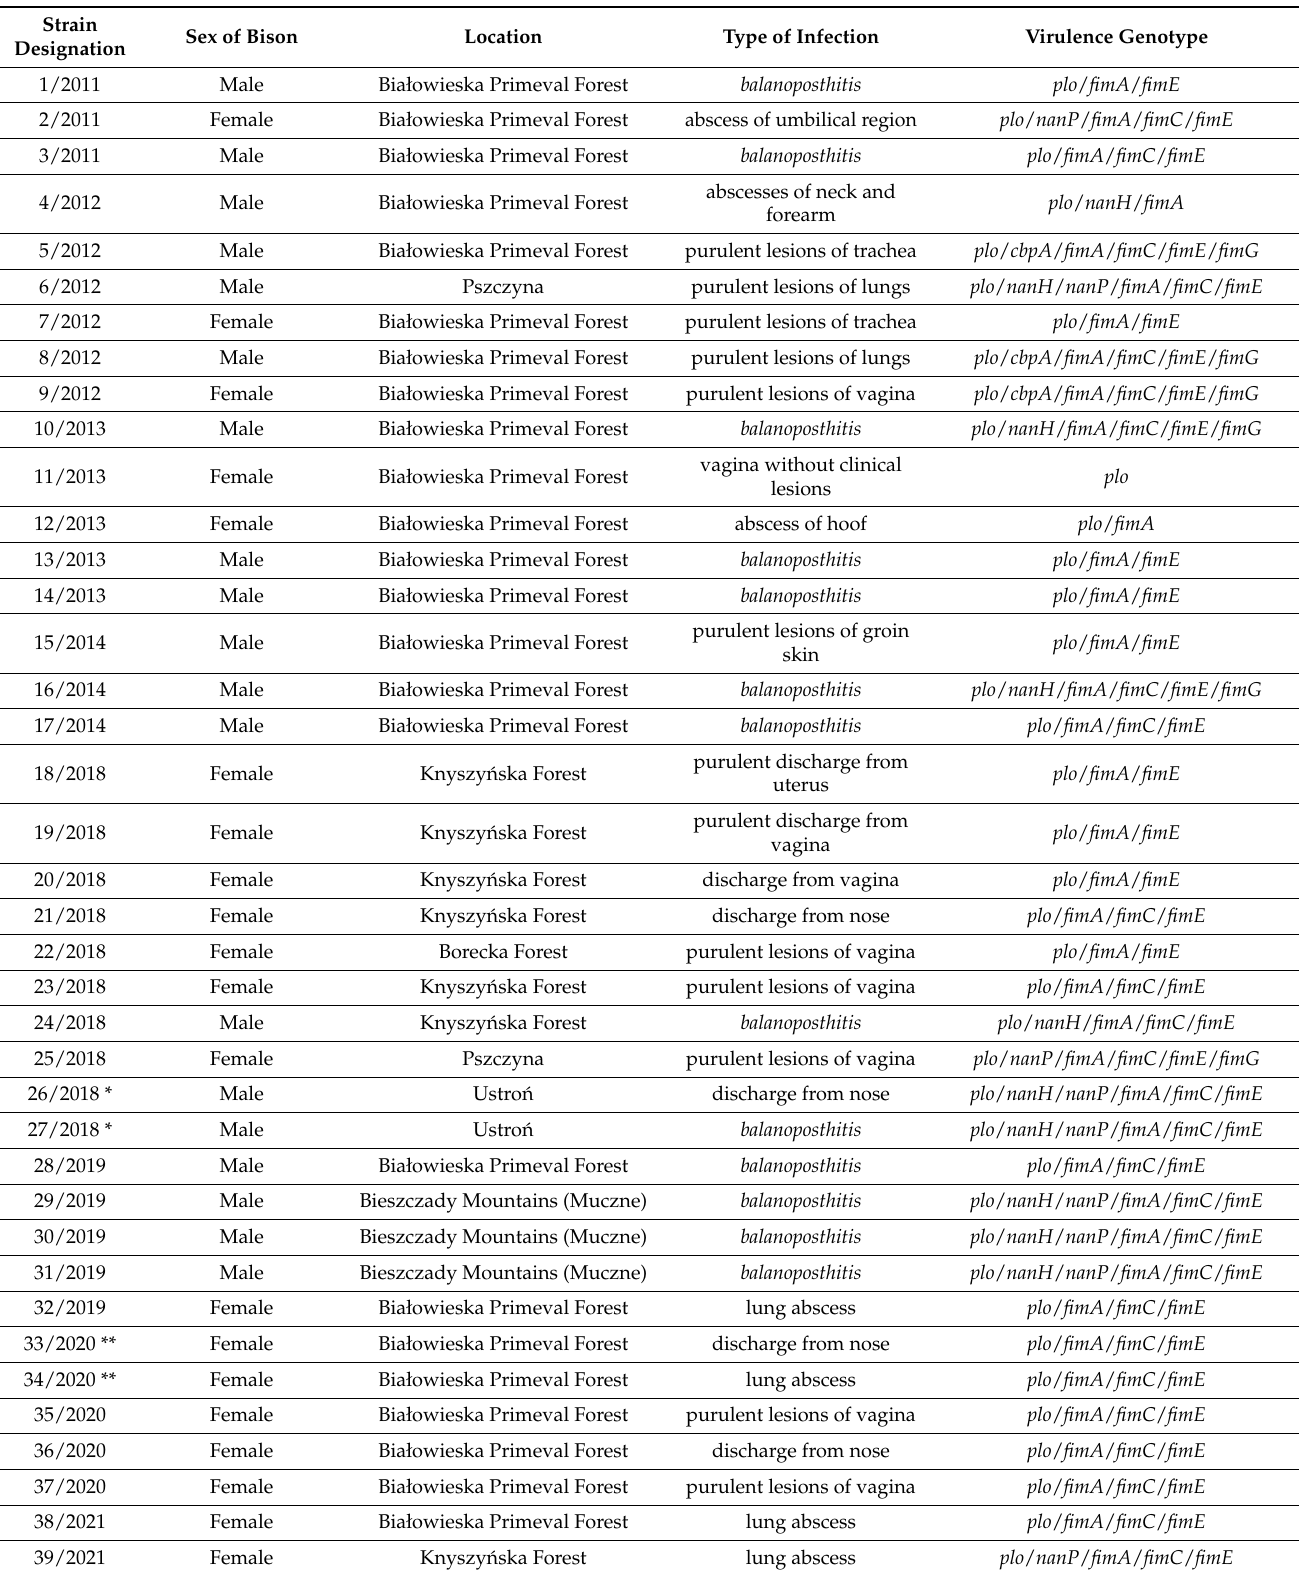
Table 2. Origin and virulence genotypes of the studied T. pyogenes strains ( n = 39) isolated from European